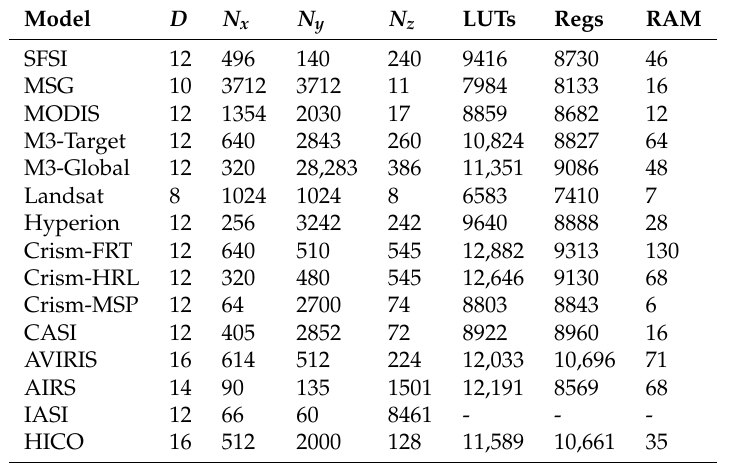
Table 1. Resource use for compressing HSI images from different sensors for N p = 4.